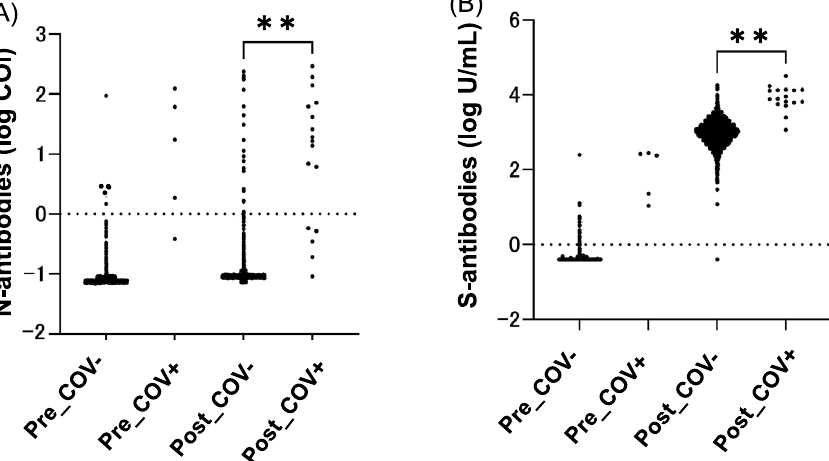
Figure 1. ( A ) Distribution of total N-specific antibodies in participants with and without history of COVID-19. Total N-specific antibody levels of pre-vaccination and post-vaccination participants with (COV+) and without (COV−) a history of COVID-19 were quantified. Statistical analysis was performed with t-testing between Post_COV- (n = 2185) and Post_COV+ (n = 17). **p value < 0.001. ( B ) Distribution of total S-specific antibodies in participants with and without history of COVID-19. Total S-specific antibody levels of pre-vaccination and post-vaccination participants with (COV+) and without (COV−) a history of COVID-19 were quantified. Statistical analysis was performed with t-testing between Post_COV- (n = 2185) and Post_COV+ (n = 17). **p value < 0.001.